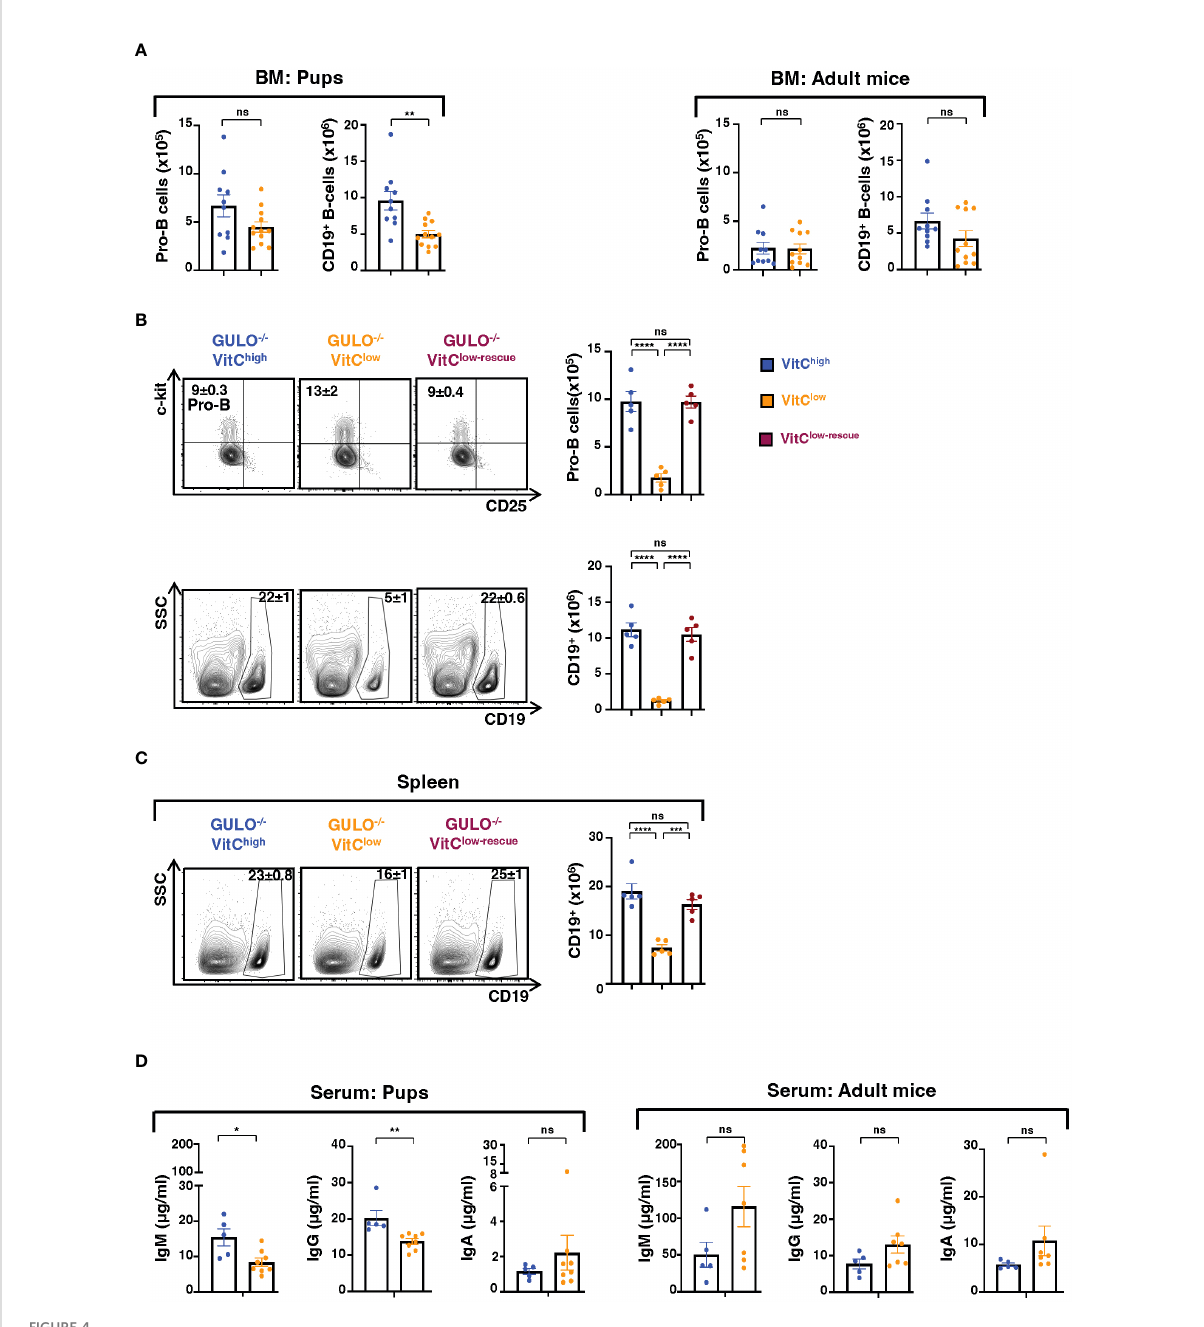
FIGURE 4 Ascorbate deprivation during the neonatal period results in a signi fi cant loss in B cell lymphopoiesis and reduced immunoglobulin production. (A) B cell differentiation was evaluated in the BM of pups (left) and adult (right) GULO -/- mice supplemented with 1g/L of vitamin C (GULO -/- VitC high ) or 0.1g/L of vitamin C (GULO -/- VitC low ). Total numbers of pro-B cells, evaluated as CD19 + c-kit + CD25 - , and CD19 + B cells were quanti fi ed and means ± SEM are shown (n=10-12 mice per group). (B) Pro-B and B lymphocytes were evaluated at day 28 in BM of GULO -/- VitC high , GULO -/- VitC low , and GULO -/- VitC low-rescue mice. Representative contour plots as well as absolute numbers of pro-B and B cells are shown (n=5 mice per group). (C) Representative contour plots of CD19 + splenic B cells in 28 day old GULO -/- mice maintained under VitC-high, VitC-low, and rescue conditions together with absolute numbers of splenic B cells (n=5 mice per group). (D) Serum immunoglobulins (IgM, IgG and IgA) were monitored in neonatal (18 day old, left) and adult (right) GULO -/- mice supplemented with high or low vitamin C by ELISA. Means ± SEM ( m g/ml) are presented (n= 5-8 mice per group). Statistical analyses were performed using an unpaired two-tailed t-test in panels (A, D) ; and a one-way ANOVA (Tukey ’ s test) in panels B-C. *p < 0.05; **p < 0.01; ***p < 0.001; ****p < 0.001; ns, not signi fi